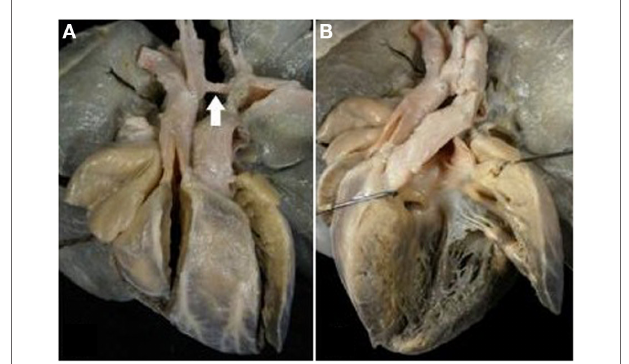
FigUre 6 | complete Tga with VsD and aortic arch obstruction . (a) External view of the heart showing the right anterior position of the aorta and the severe hypoplasia of the aortic arch between carotid and subclavian artery (arrow). (B) The pulmonary artery takes origin from the left ventricle. Note the malaligment VSD with the infundibular septum deviated to the right.